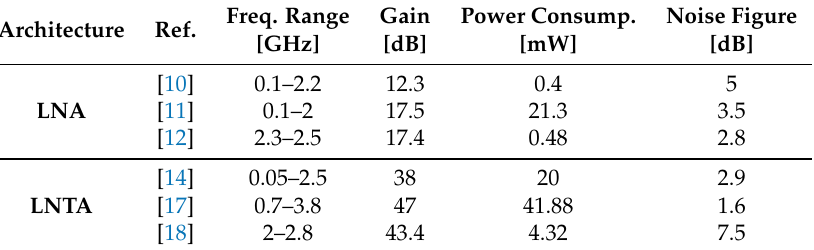
Table 1. Characteristics of the selected LNA and LNTA-based